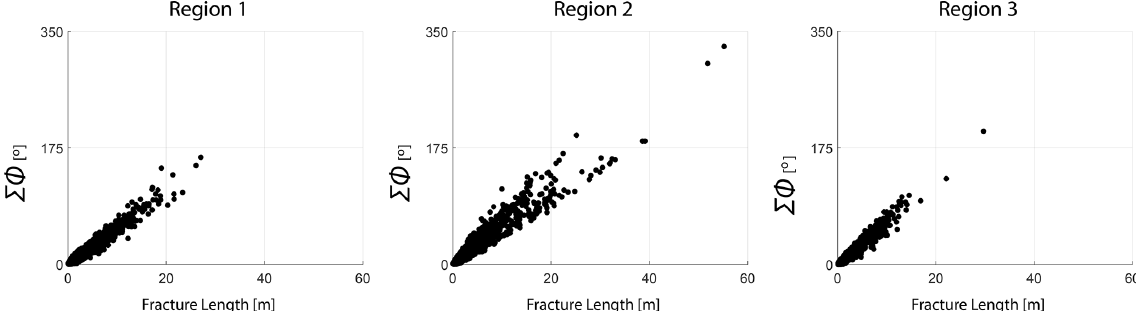
Figure 6. Correlation between sum of strike differences of fracture segments constituting tip-to-tip fractures versus total fracture length for the three